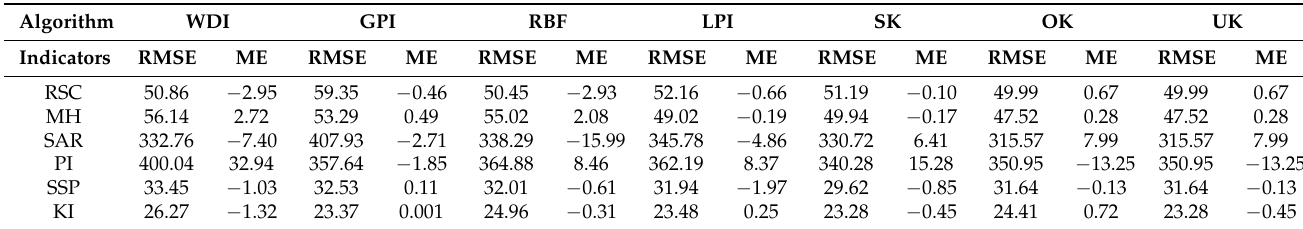
Table 1. Performance of interpolation methods.